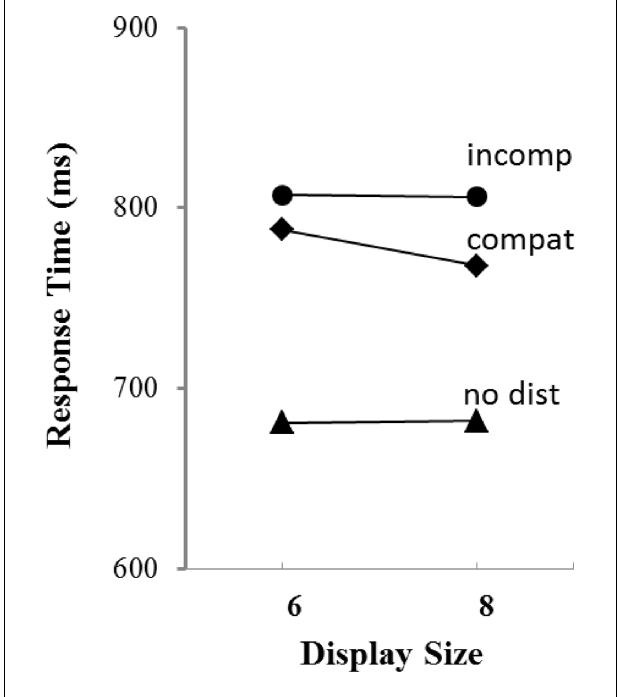
FIGURE 2 | Mean response time as a function of display size and distractor type in Experiment